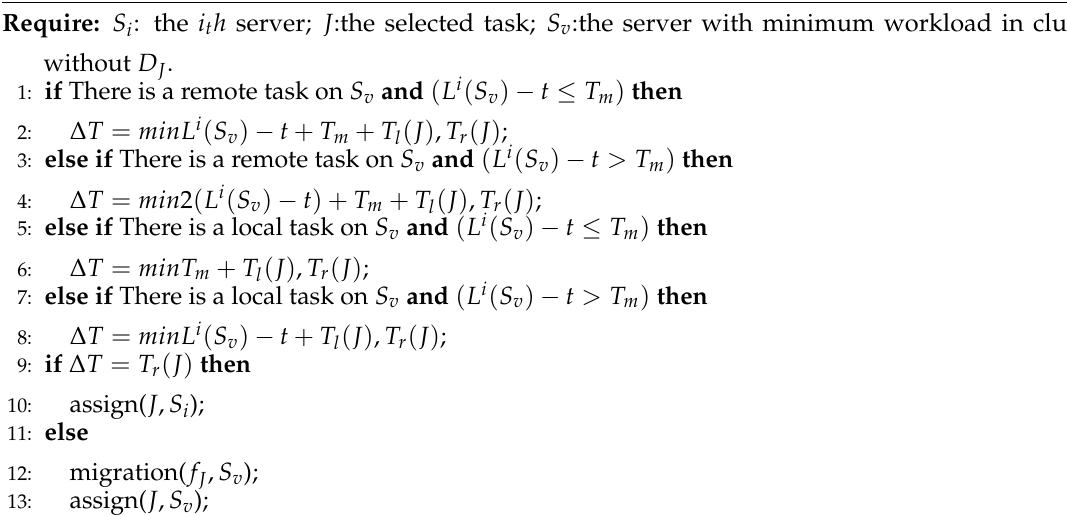
Algorithm 2 ScheduleTaskwithDataMigration( J